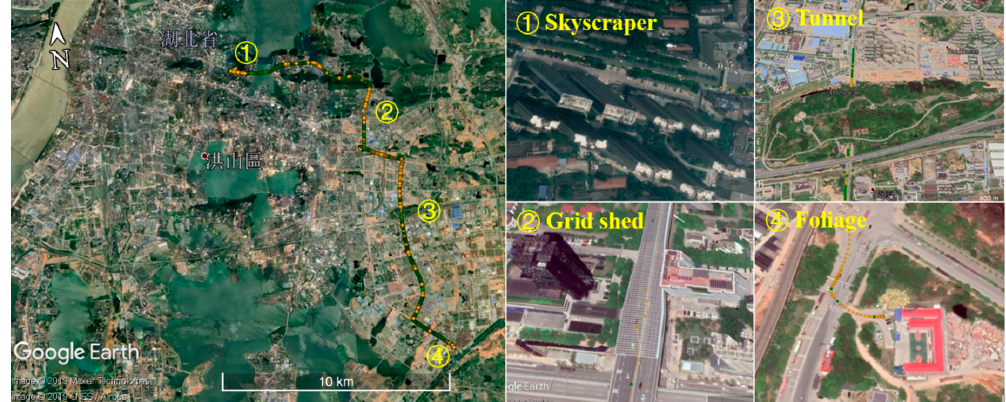
Figure 11. Trajectory and four typical GNSS challenging environments of test #2.